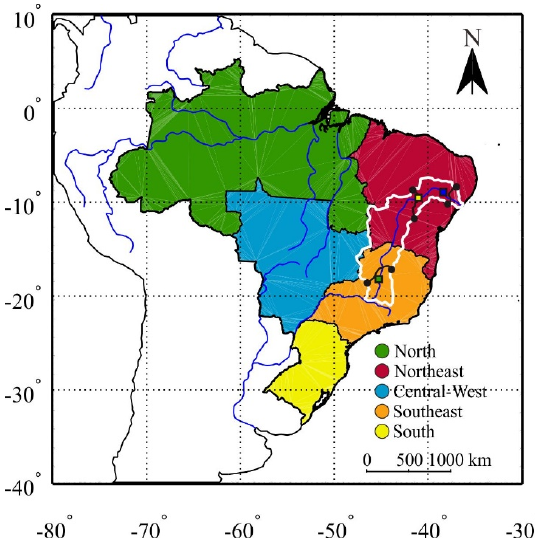
Figure 1. Regions of Brazil divided as North, Northeast, Central-West, Southeast, and South (black solid lines) and the SFRB (white solid line) with its main four physiographical regions (approximately defined by the black solid lines with dots on their extremities). The solid blue lines show the major rivers. The squares within SFRB indicate the location of each reservoir, i.e. , Três Marias (green), Sobradinho (yellow), and Luiz Gonzaga (blue). The scale bar refers to the centre of the map.